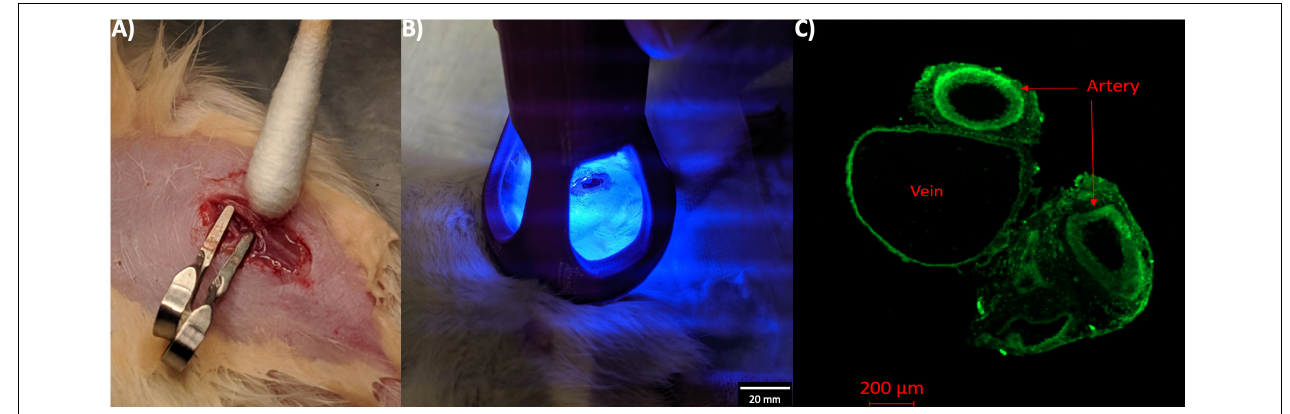
FIGURE 1 | NVS treatment of AVF. (A) AVF surgery area was incubated with NVS solution for 5 min. (B) NVS was activated by laser at 450 nm for 1 min. (C) Fluorescent images of native blood vessels that were harvested immediately after the NVS and laser treatment. Green fluorescence indicates NVS penetration throughout the anastomosis